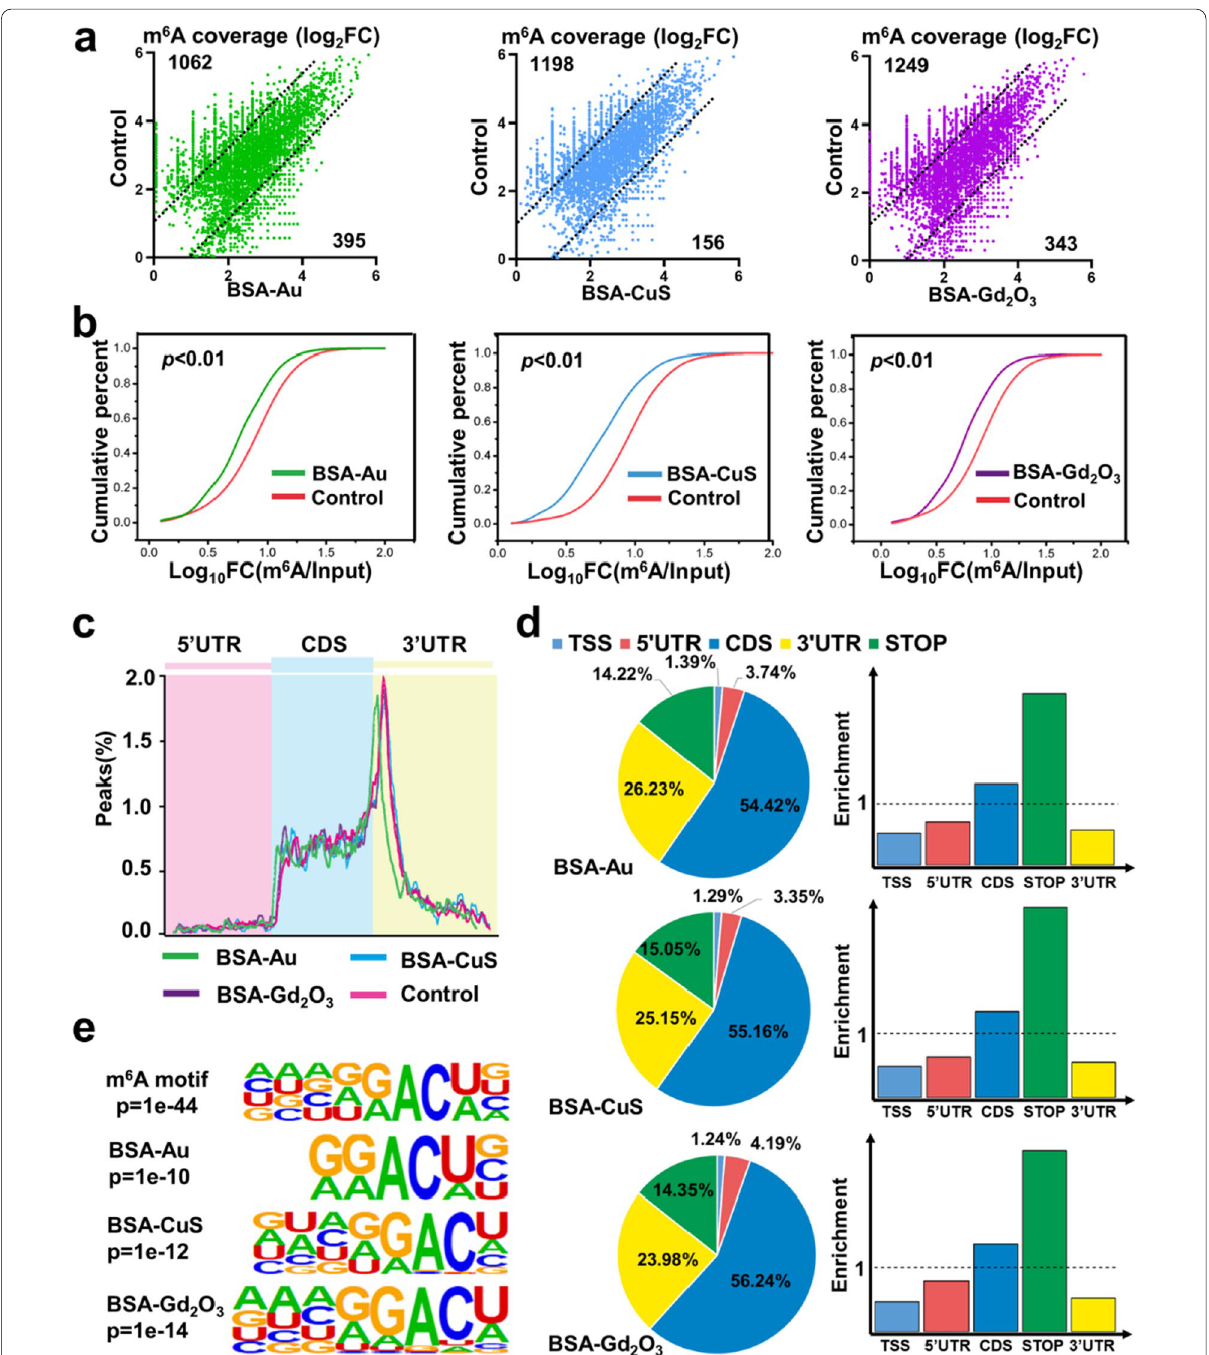
Fig. 3 Global m 6 A changes induced by BSA-templated NPs. a Scatter plots showing the variation of m 6 A coverage of individual m 6 A sites in cells treated with BSA-templated NPs. Pair-wise comparison was shown between BSA-Au NPs (left), BSA-CuS NPs (middle), BSA-Gd 2 O 3 NPs (right), and controls, respectively. The dashed lines indicated cut-off of log 2 FC(BSA-templated NPs/Control) (1 or downregulated (log 2 FC < -1) or upregulated (log 2 FC > 1) m 6 A level was shown. FC, fold change. b Cumulative frequency of m 6 A targeted genes upon BSA-templated NPs exposure. P values were calculated using two-sided Wilcoxon and Mann–Whitney test. c Metagene profile of enrichment of m 6 A-targeted sites across mRNA transcriptome. 5’UTR, 5’ untranslated region; CDS, coding sequence; 3’UTR, 3’ untranslated region. d The distribution (left) and enrichment (right) of m 6 A peaks within different gene regions. Enrichment was determined by the proportion of m 6 A peaks normalized by the length of the region. e Top consensus sequences of m 6 A-targeted